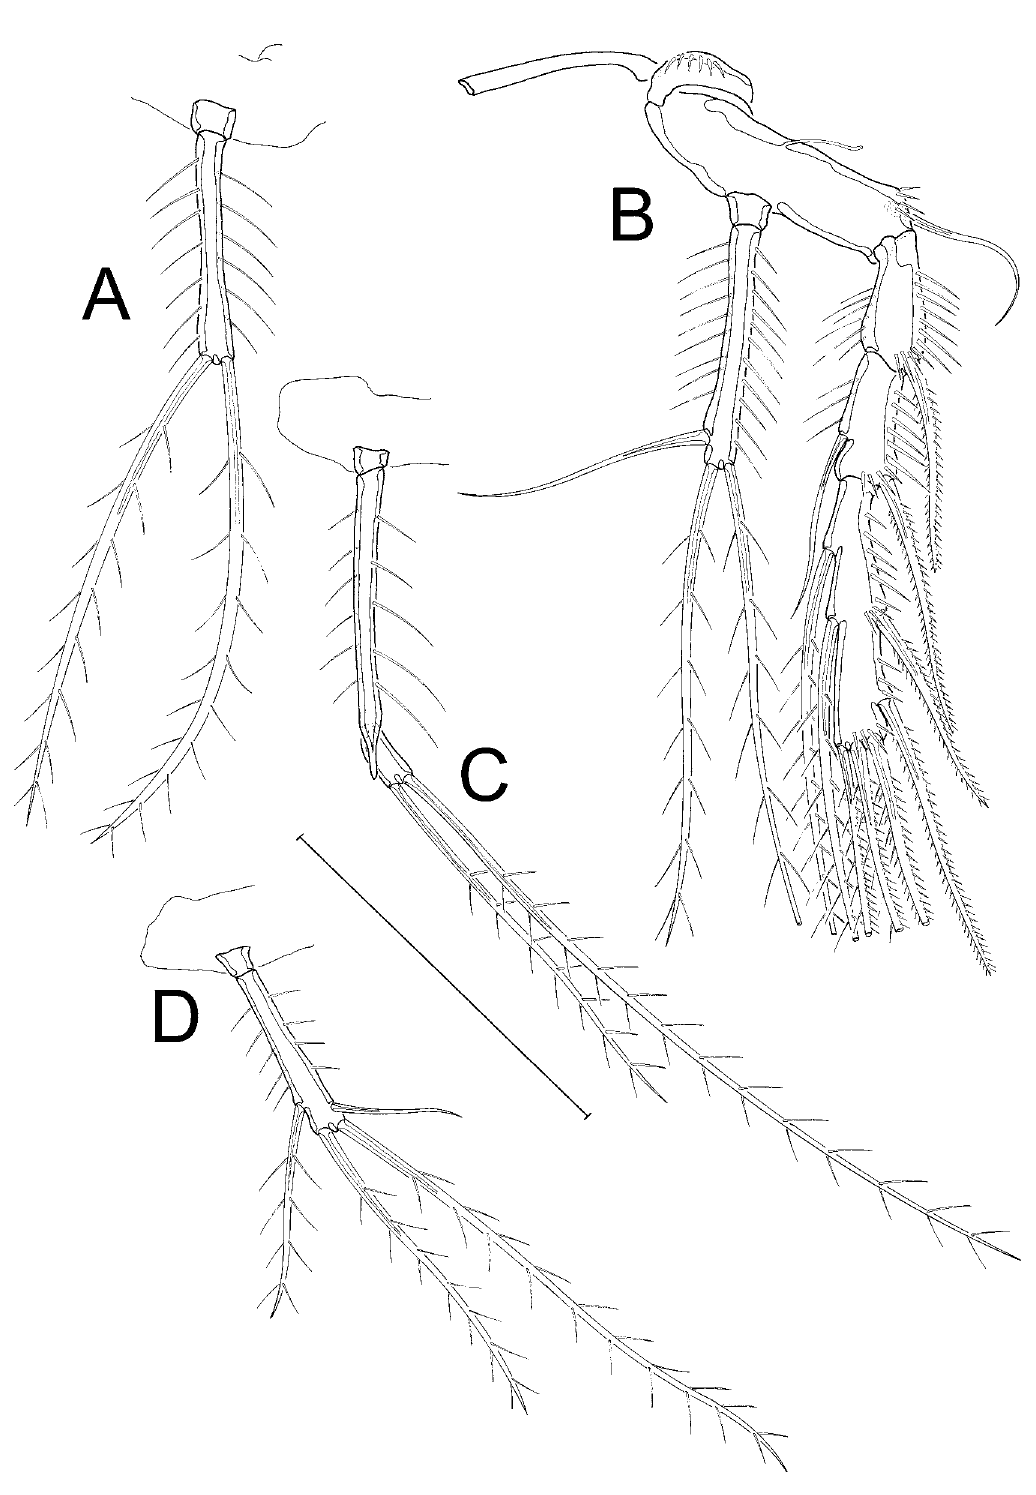
Fig. 19. Laophontodes monsmaris sp. nov. A . Paratype, ♀, (SMF 37122/1), P3 enp. B . Allotype, ♀, (SMF 37121/1), P4. C . Paratype, ♂, (SMF 37125/1), P3 enp. D . Paratype, ♂, (SMF 37125/1), P4 enp. Scale = 50